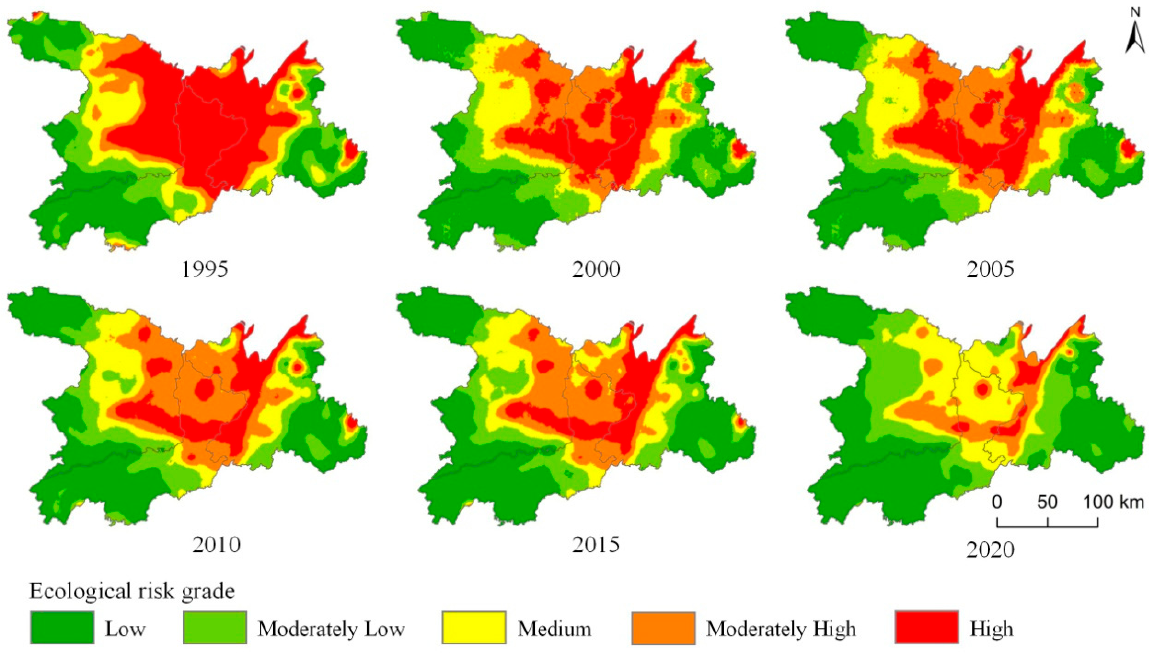
Figure 4. Spatial pattern of ecological risk distribution in Dongting Lake area from 1995 to 2020.